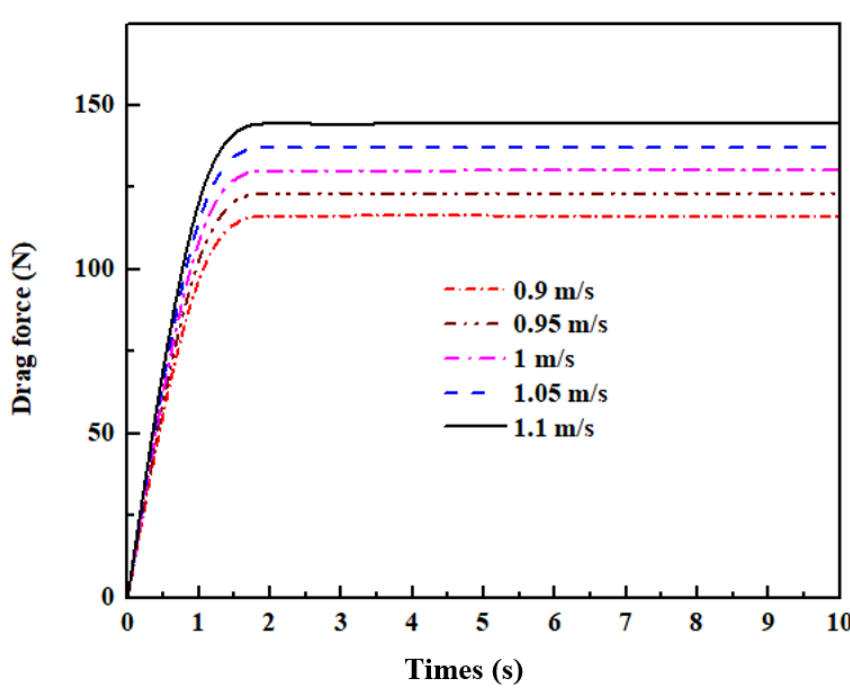
Figure 6. Drag forces acting on the glider body with the angle of attack θ = −10 ° at the different velocities.